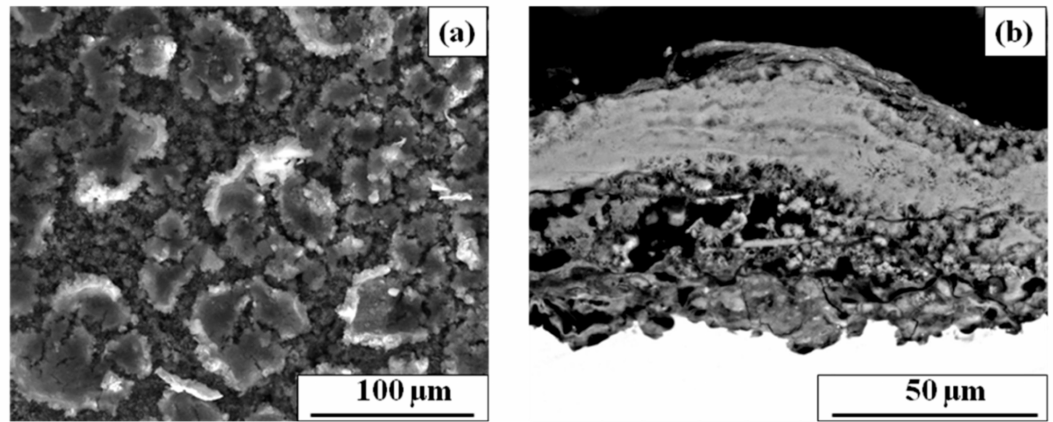
Figure 11. The surface ( a ) and cross-sectional ( b ) morphology of the samples without phosphoric acid mixed in the tannic rust converter application (adjusting the pH value to 0.38 by